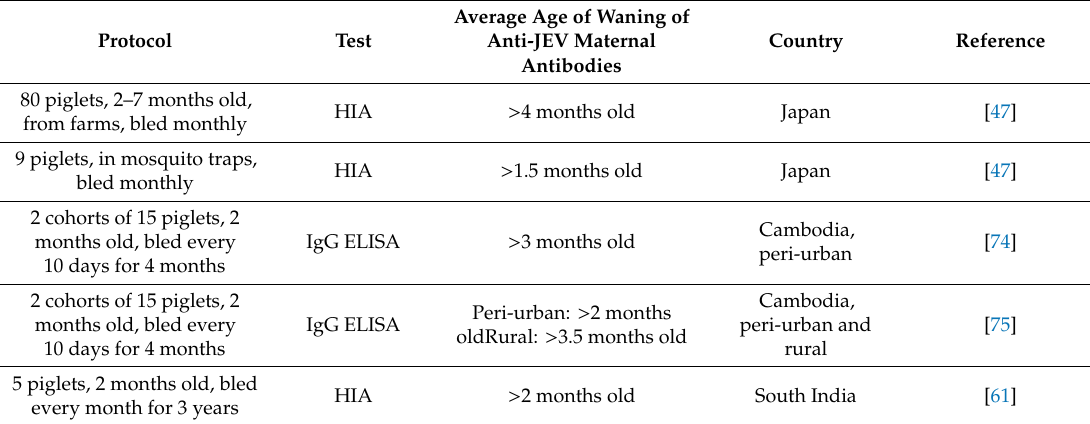
Table 4. Persistence of anti-JEV maternal antibodies in piglets under field conditions. Protocol Test